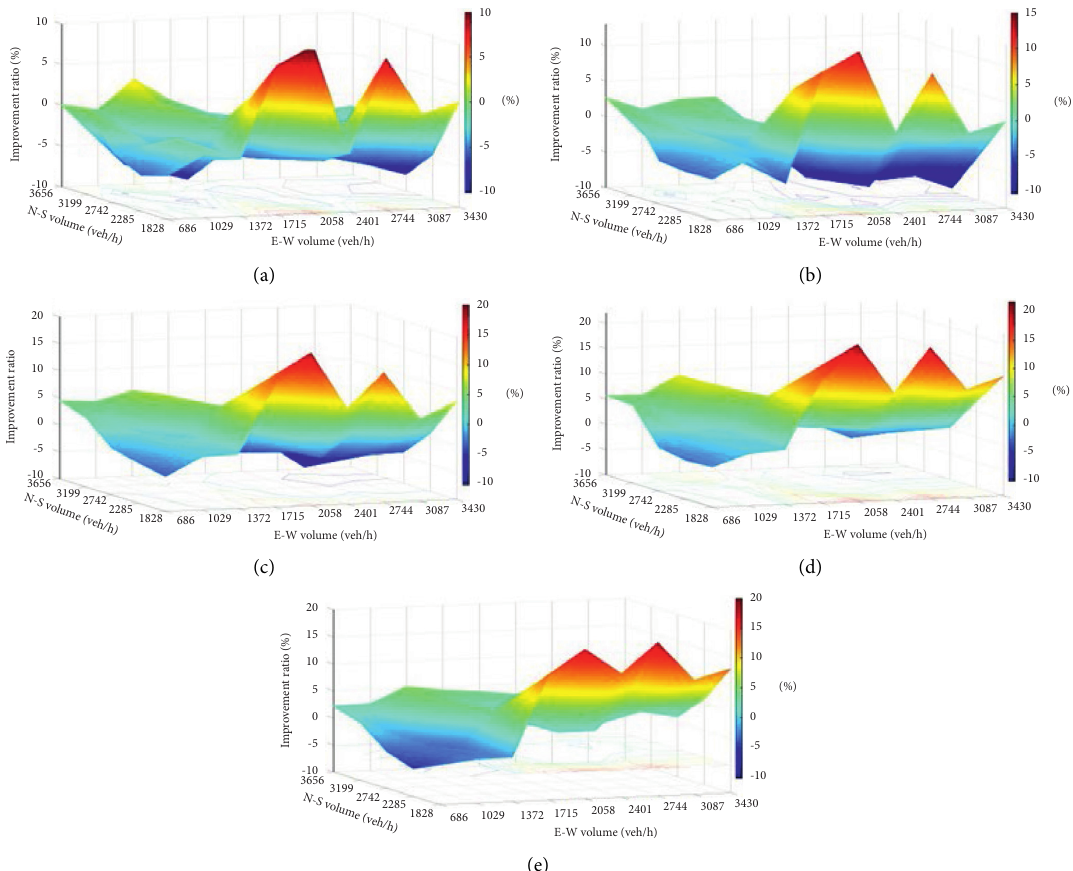
Figure 12: Improvement ratios of the NOx emissions. (a) Scheme 1. (b) Scheme 2. (c) Scheme 3. (d) Scheme 4. (e) Scheme 5. E-W volume means the same traffic volume of east entrance and west entrance. N-S volume means the same traffic volume of north entrance and south entrance.